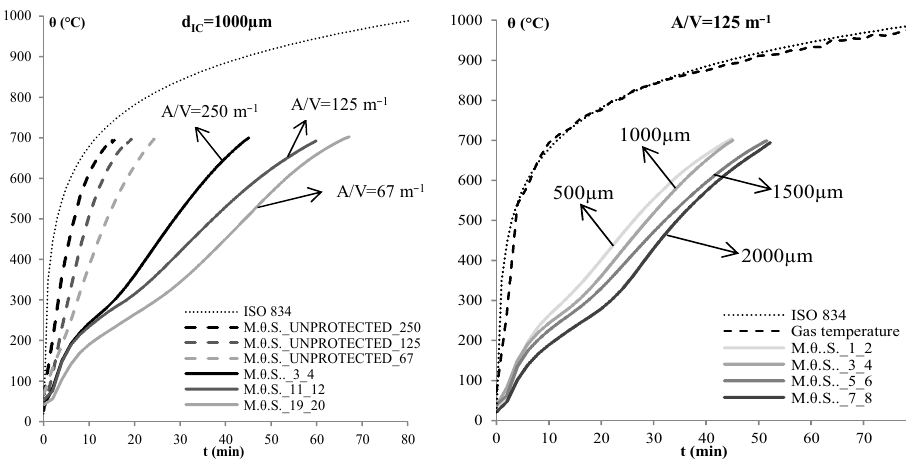
Figure 9. The temperature evolution in steel samples.